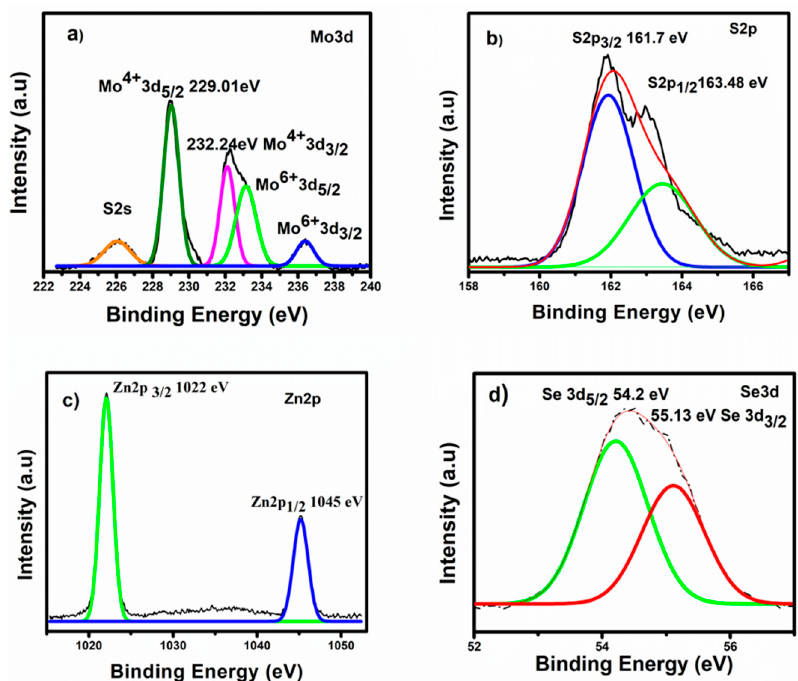
Figure 2. XPS spectra of ( a ) Mo 3d, ( b ) S 2p, ( c ) Zn 2p and ( d ) Se 3d orbitals.